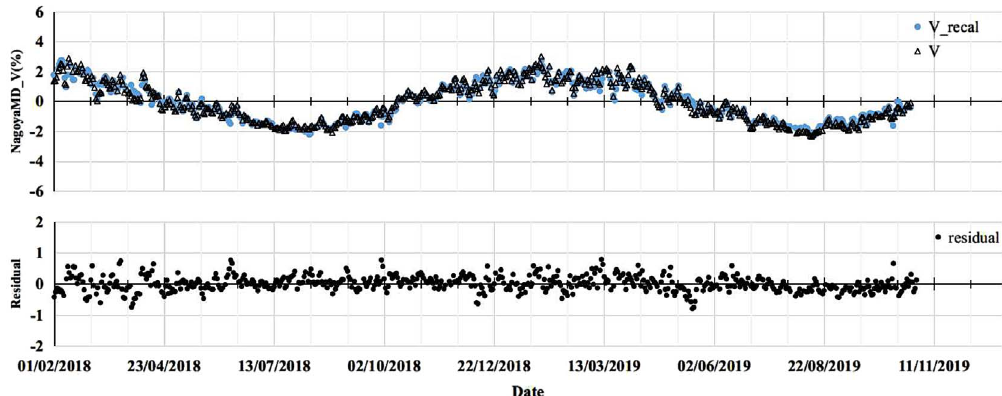
Fig. 12. Top: Daily average count rate variation of Nagoya MD (open triangle) and reproduced variation by atmospheric temperature (blue circle). Bottom: The observed variation corrected for the atmospheric temperature effect. Minor tick marks on the horizontal axis are indicated every 27 days.